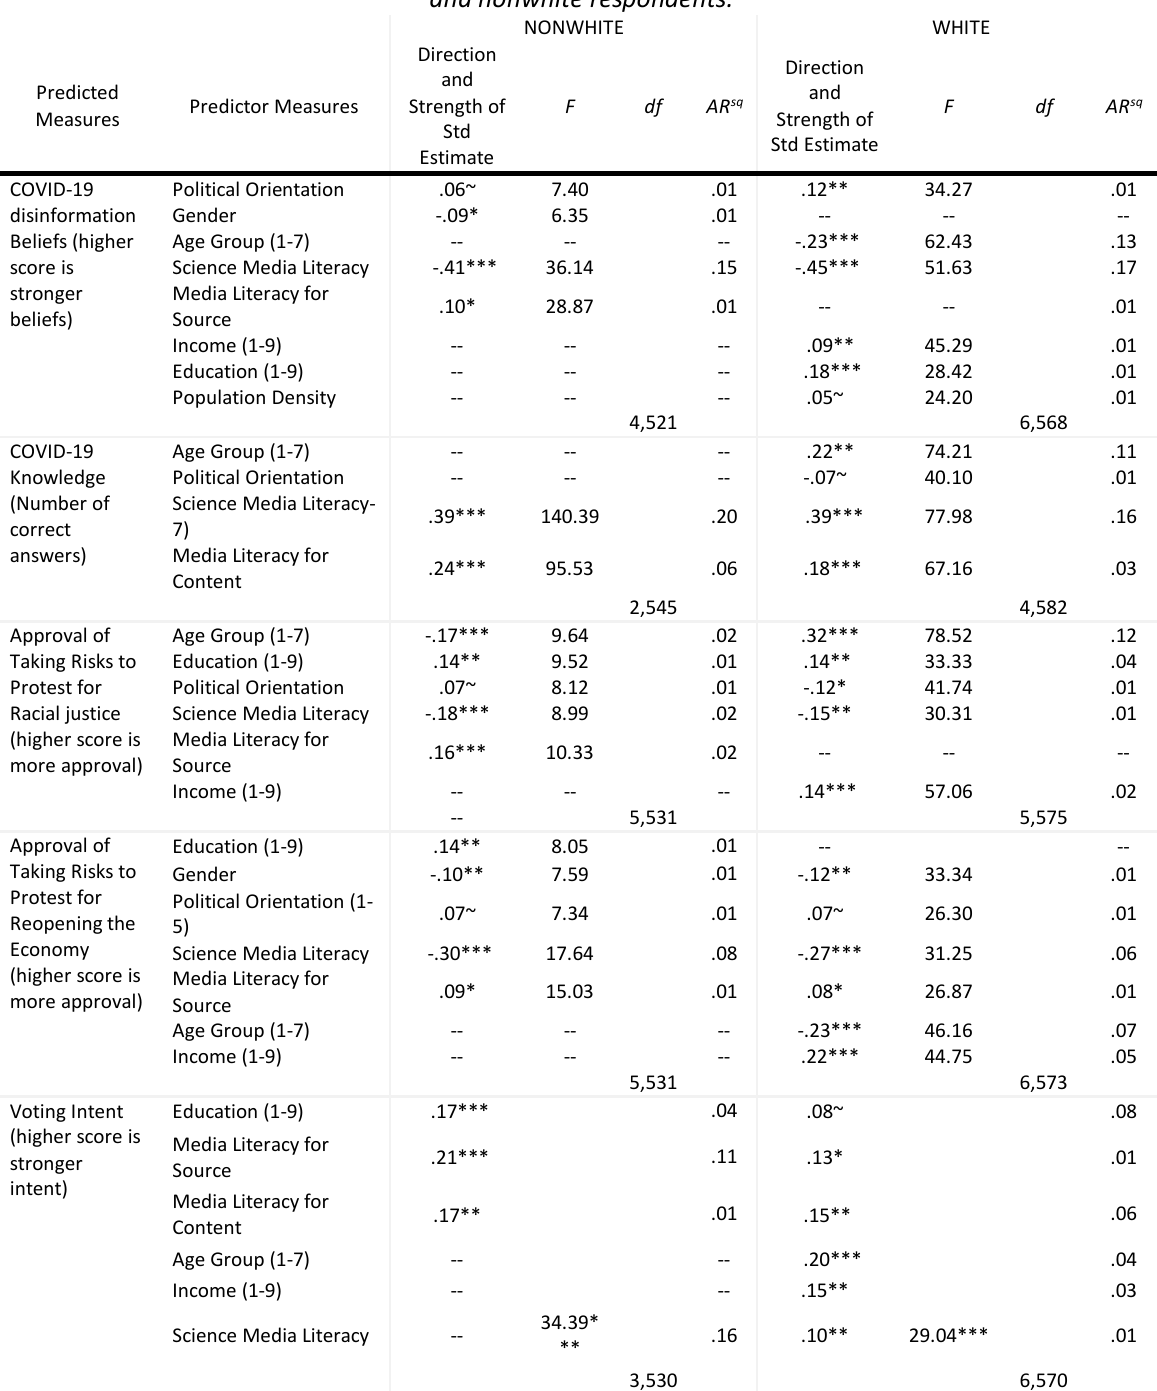
Table 3. Media literacy and demographic associations with political engagement for white and nonwhite respondents. NONWHITE